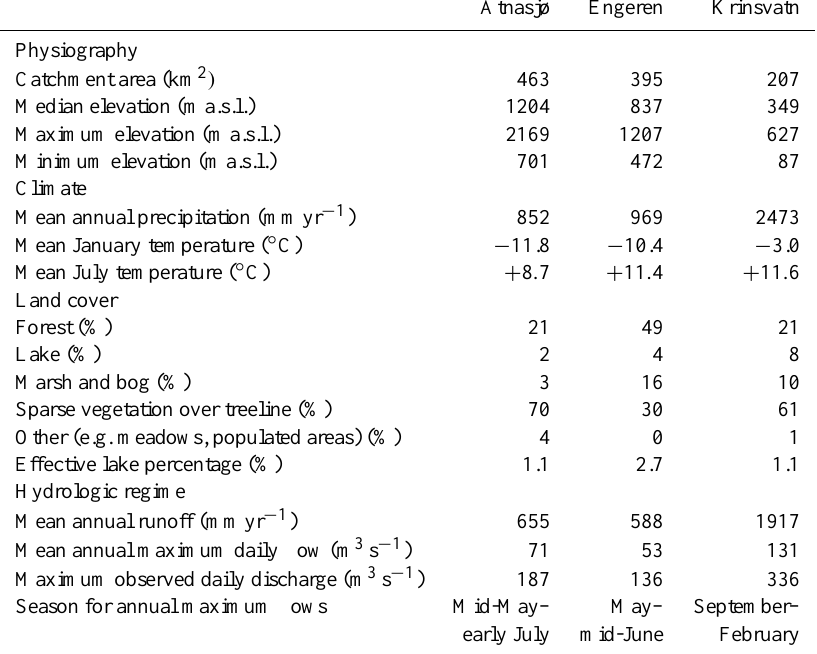
Table 1. Catchment